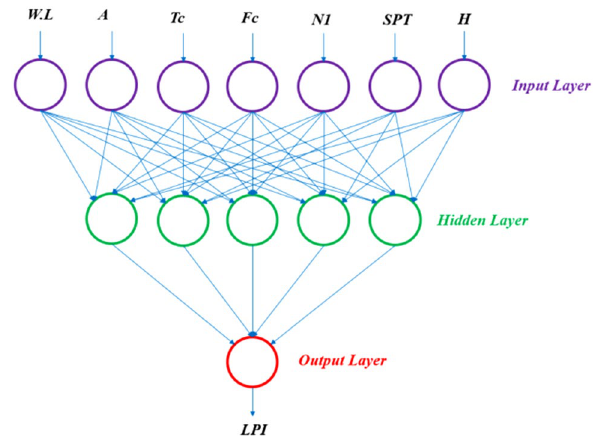
Fig. 18 The configuration of the ANN1 for liquefaction